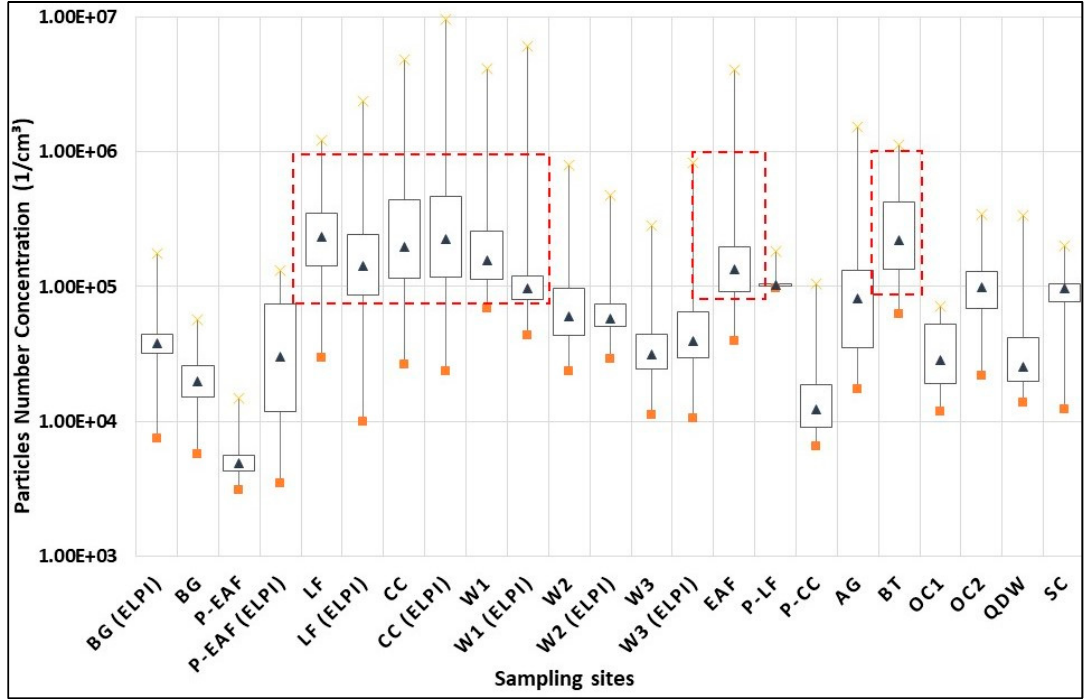
Figure 3. Median, interquartile range, minimum and maximum UFP number concentration measured through stationary, quasi-personal and personal samplings. Red boxes show the highest UFPs median number concentrations measured.